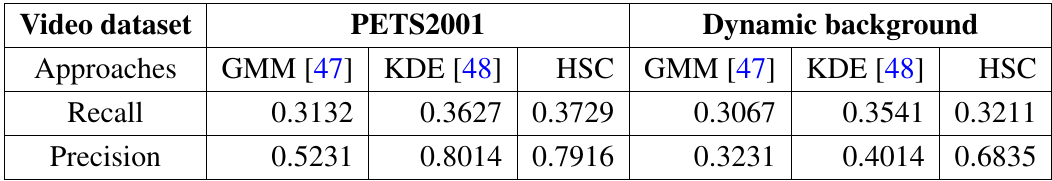
Table 3. Peformance evaluation for moving object